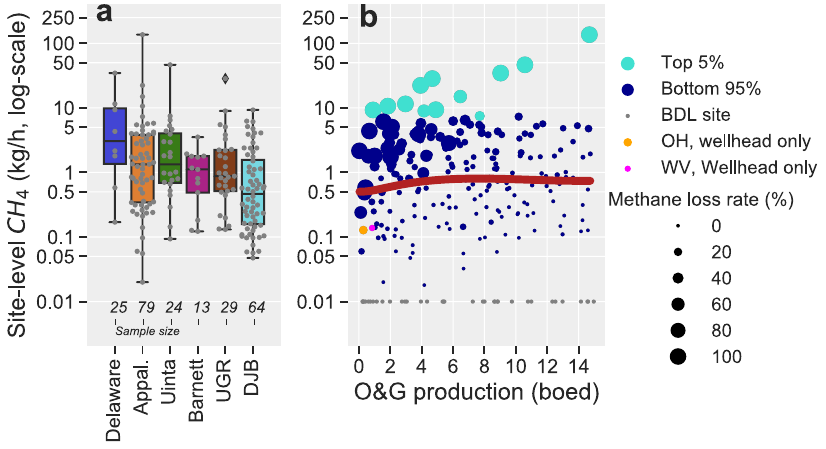
Fig. 3 Low production well site CH 4 emissions data as reported in previous studies. a CH 4 emissions data for six basins with at least n > 5 observations shown as box plots (centerline, median; box limits, upper and lower quartiles; whiskers, 1.5× interquartile range) and individual points (gray circles). Sample sizes are shown at the bottom of the plot. Only site-level measurements above method detection limits of 0.01 – 0.036 kg/h are shown. Appal. — Appalachian (Pennsylvania, Ohio, West Virginia); Delaware (Texas/New Mexico); Barnett (Texas); Uinta (Utah); UGR — Upper Green River (Wyoming);